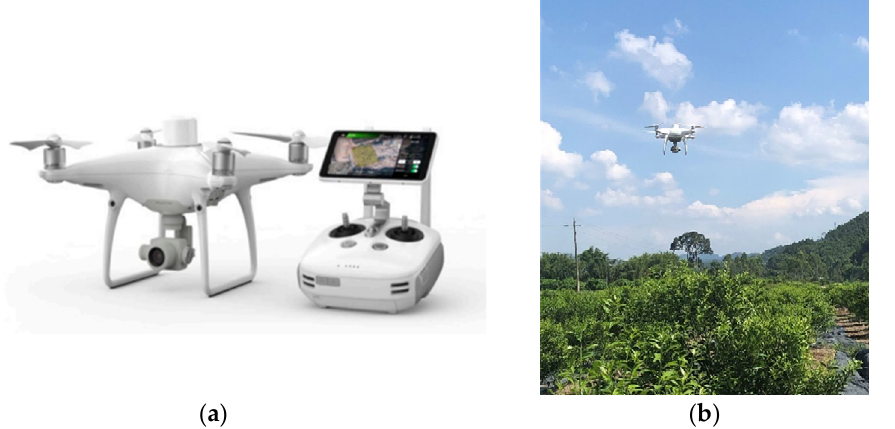
Figure 2. UAV tilt photogrammetry images acquisition: ( a ) DJI Phantom 4 RTK UAV; ( b ) Image acquisition in orchard.